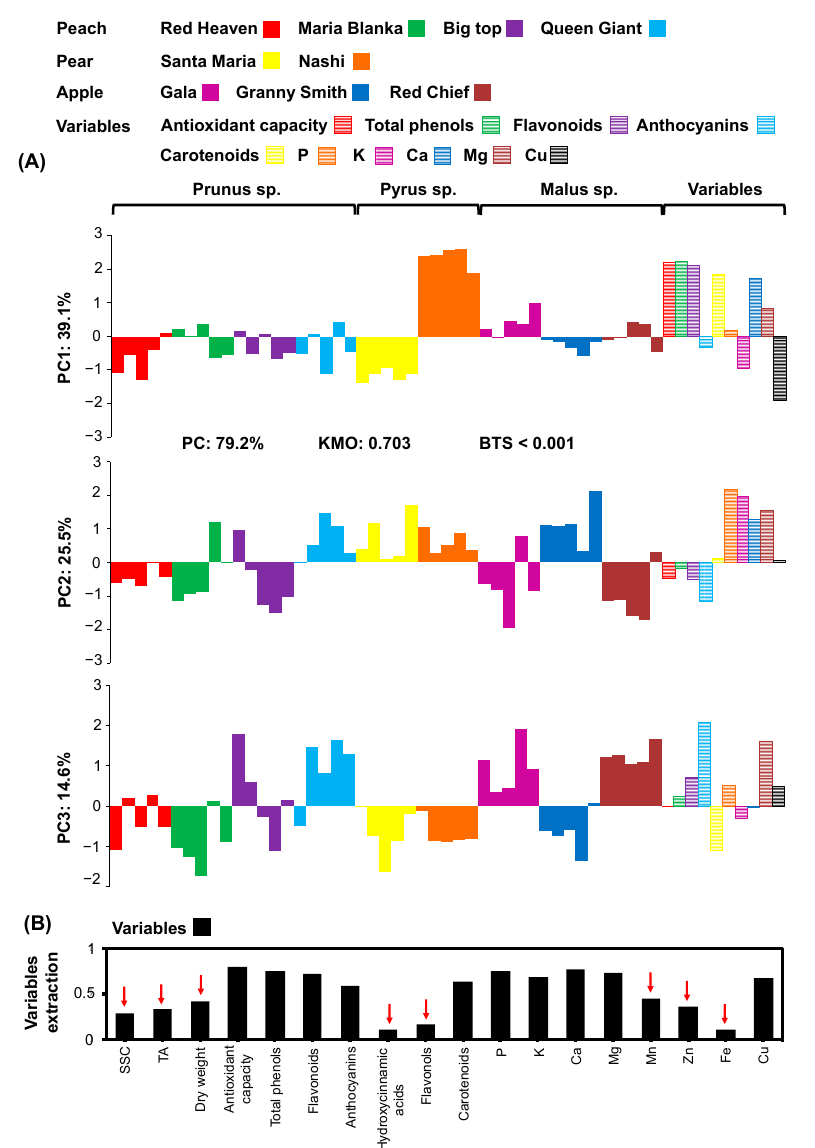
Figure 4. Principal component analysis (PCA) ( A ) for PC1, PC2, and PC3 of physio-biochemical and elementary log-ratios (bars filled with horizontal lines) between unpeeled and peeled fruits expressed as logarithm base two of four peach cultivars (Red Heaven: red, Maria Bianca: green, Big Top: purple, Queen Giant: light blue), two pear cultivars (Santa Maria: yellow, Nashi: orange), and three apple cultivars (Gala: lilac, Granny Smith: blue, Red Chief: brown; bars filled with color). Eighteen physio-biochemical and mineral variables extraction ( B ) based on the representation in the PCA model (red arrows indicate variables with a low representation in the PCA model).